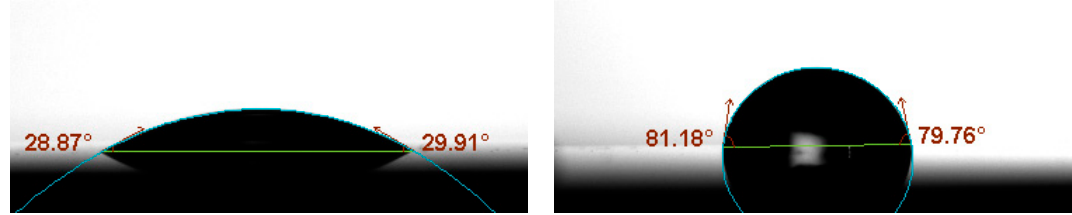
Figure 6. Water contact angle (WCA) test for ( left ) the bare SOI chip and ( right ) the SOI chip after triethoxyvinyl–silane (TEVS) silanization.